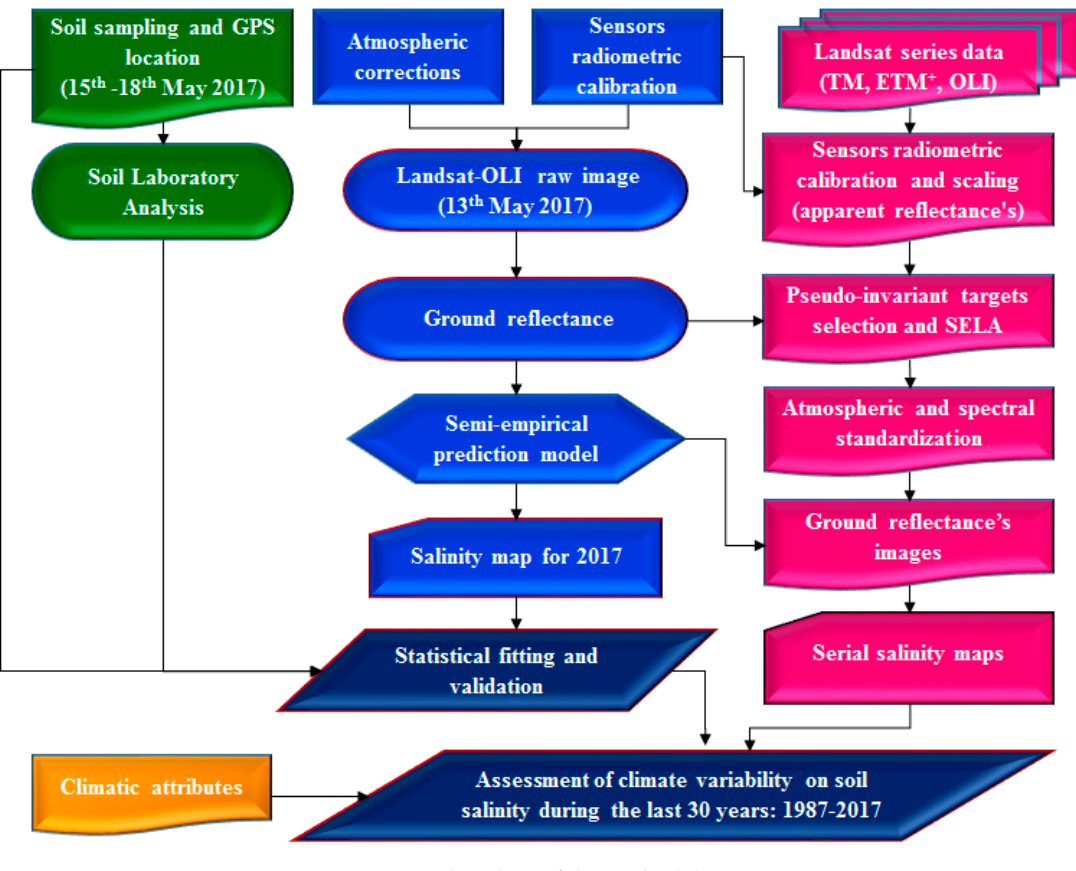
Figure 1. Flowchart of the methodology.